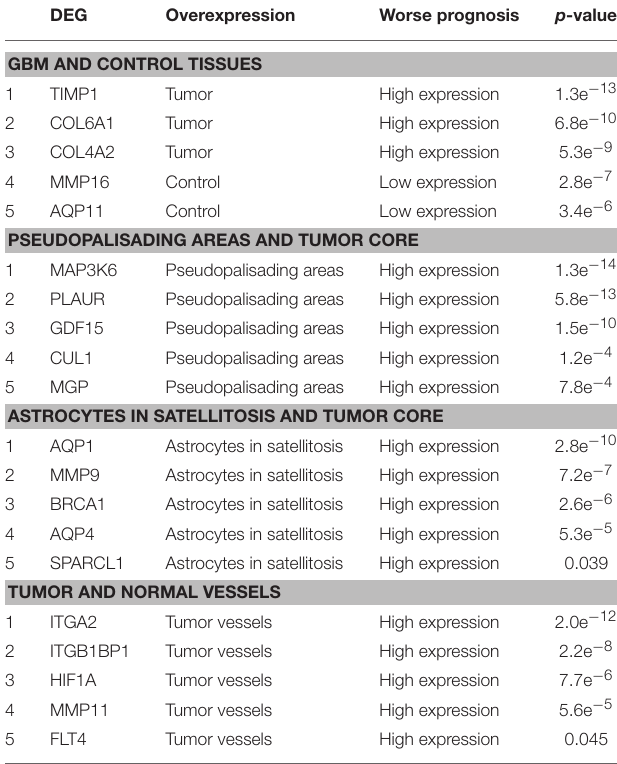
TABLE 5 | Association between DEGs from functional enrichment analysis and survival